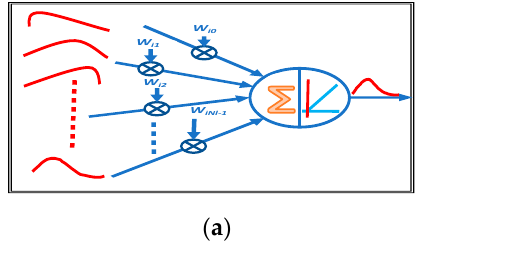
Algorithm 1 Generate Binary Stream of Spikes